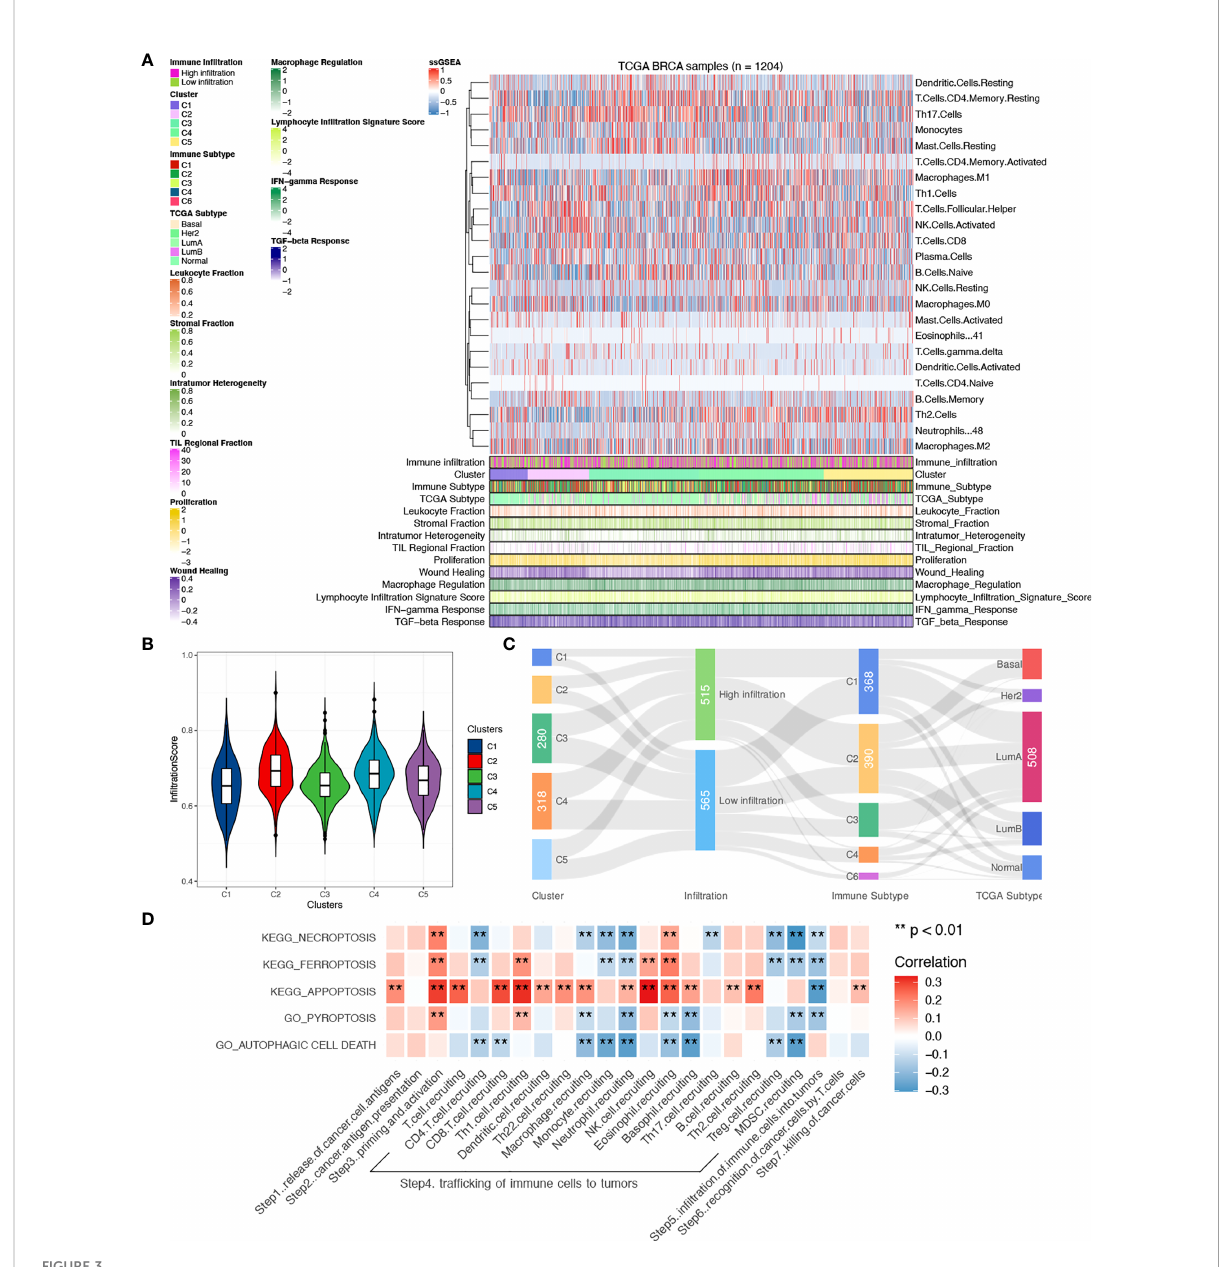
FIGURE 3 Comparisons of tumor microenvironment between clusters. (A) Heatmap of tumor-in fi ltrating immune cells between clusters with previously categorized immune subtypes information. (B) Comparisons of in fi ltration scores were done between clusters. (C) Correlations between clusters and immune subtypes, PAM50, and in fi ltration levels. (D) Correlations of PCD pathways and the seven-step Cancer-Immunity Cycle in all samples. A two-sided P -value < 0.05 was considered signi fi cant. **P <